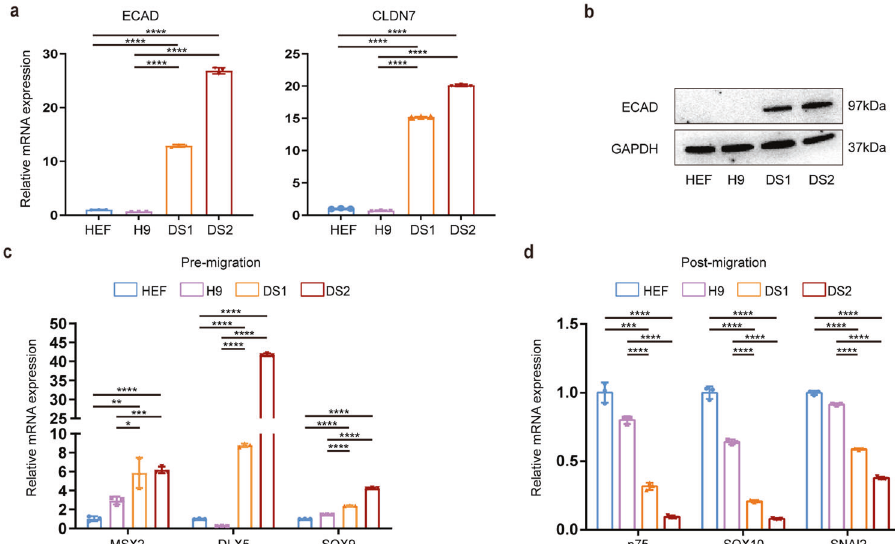
Fig. 2 Migration- and EMT-related markers were differentially expressed between the trisomic and euploid cells. a qPCR assay for epithelial markers (ECAD, CLDN7) in day 7 cells. b Western blotting analysis for the protein expression level of ECAD in day 7 cells. c qPCR assay for premigratory markers (MSX2, DLX5, SOX9) in day 7 cells. d qPCR assay for postmigratory markers (p75, SOX10, SNAI2) in day 7 cells. Data are presented as the mean ± SD of three independent experiments. n = 3. * P < 0.05, ** P < 0.01, *** P < 0.001, **** P < 0.0001, two-tailed unpaired Student ’ s t